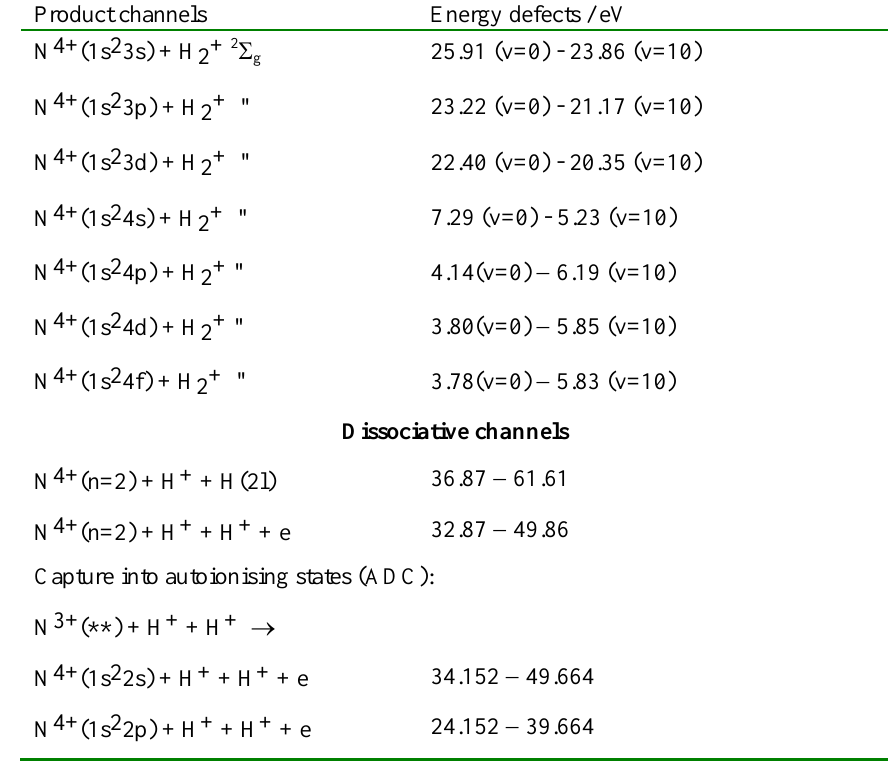
Table 5. Main product channels for the N 5+ (1s 2 ) 1 S + H